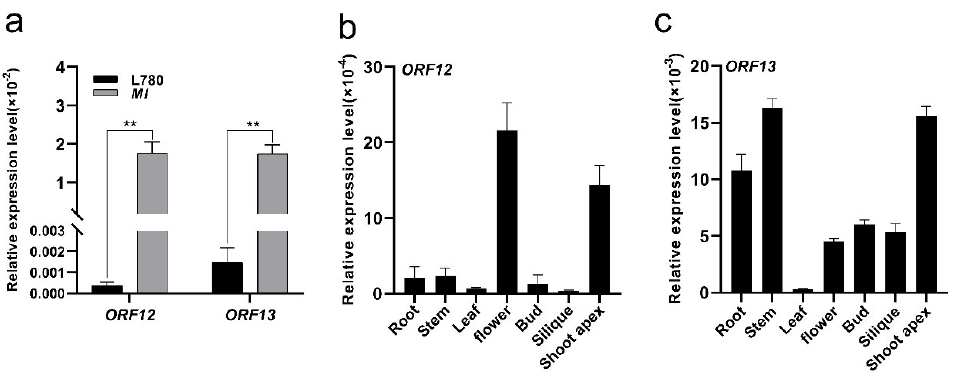
Figure 6. Relative expression and expression pattern of ORF12 and ORF13 . ( a ) Relative expression of ORF12 and ORF13 in SAM of MI . Expression pattern of ORF12 ( b ) and ORF13 ( c ) detected by qRT − PCR in roots, stems, leaves, flower, buds, siliques, and shoot apex of MI . Values are expressed as average ± SD (n = 3). Student’s t test was used for statistical analysis; values are the mean ± standard deviation (SD) of three biological replicates ( ** p < 0.01).